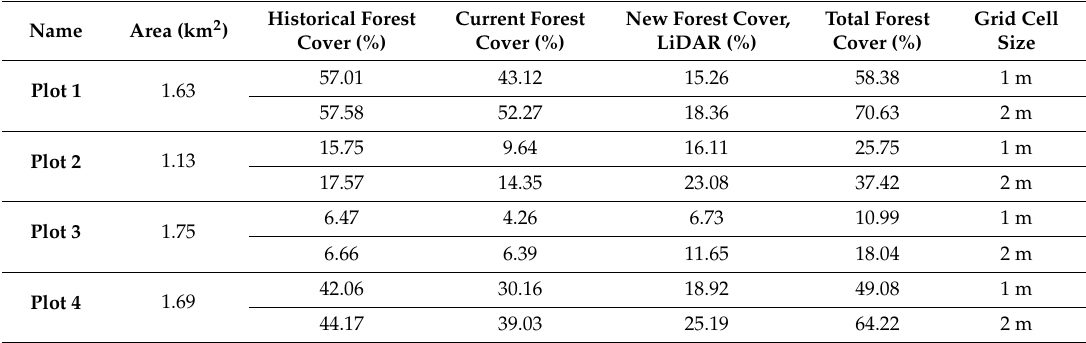
Table 5 juxtaposes the land-use structure, including areas covered by tall vegetation (for all practical purposes, this is forest resulting from a ff orestation of agricultural land and secondary forest succession). It includes areas covered by forest vegetation in 1966 and 2012, areas with new forest cover after 1966, and the total surface area of tall vegetation from both datasets. Table 5. Forest cover surface area analysis. The table contains data for plots developed for a grid cell size of 1 m and 2